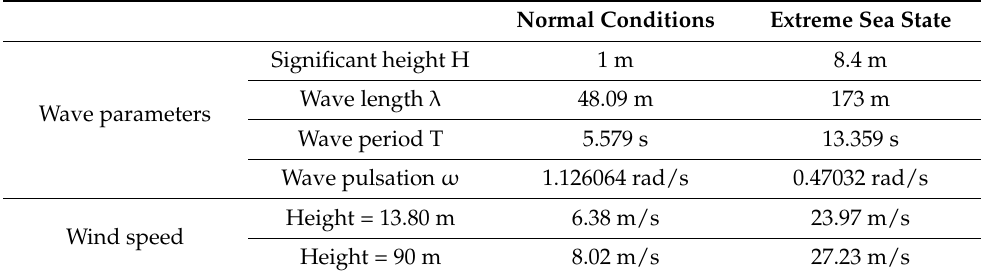
Table 2. Wave parameters and wind speed in normal conditions and extreme sea